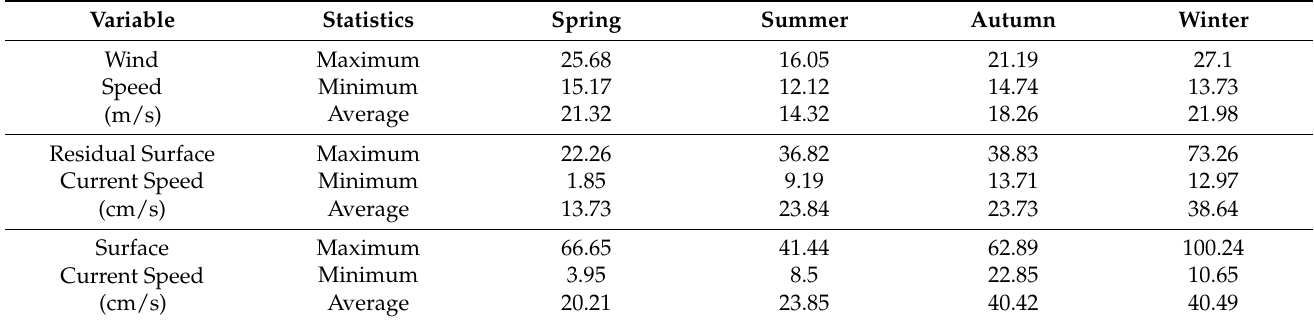
Table 2. Statistics of the maximum wind for each